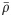
Slopes of tie lines within elliptic binodals are important for systems that undergo phase separation via obligate heterotypic interactions.The ellipse is drawn to fit the locus of points based on the value ρ¯ that meets our criteria for a density transition (see main text). Data for constructing the ellipse were taken from simulations of the N130 + rpL5 system–see Fig 11(A). This ellipse is used to assess the impact of slopes of tie lines for a two-component system comprising of macromolecule A that undergoes phase separation via obligate heterotypic interactions with macromolecule B. (a) Ellipse with nearly horizontal tie lines. The vertical lines shown in green, grey, and blue correspond to fixed values for [B] along the abscissa. As [A] increases, the system traverses across the two-phase regime, delineated by the ellipse, starting outside the ellipse, crossing the ellipse, and exiting the ellipse at high concentrations of A. (b) For each fixed value of [A], the plot shows how [A]Sol varies with [A]. The red points on each curve were extracted from within the two-phase regime, whereas the black points lie outside the two-phase regime. Clearly, [A]Sol does not stay fixed as [A] increases. (c) Equivalent plot to that shown in panel (a) for the tie lines that we obtain for the N130 + rpL5 system. (d) Equivalent plot to that shown in panel (b). Note the non-linear variation of [A]Sol as [A] increases. (e) Ellipse annotated with vertical tie lines. In this case, phase separation of [A] does not depend on obligate heterotypic interactions with B, but B can bind to A and has a choice of binding preferentially to A in either the dense or dilute phase. Here, A becomes the macromolecule and B the ligand. (f) Preferential binding of the ligand to the macromolecule in its dilute phase will shift the saturation concentration, assessed in terms of [A]Sol, upward and this shift will depend on [B]. Accordingly, the plateau value of [A]Sol in the two-phase regime shifts to higher values for higher values of [B].